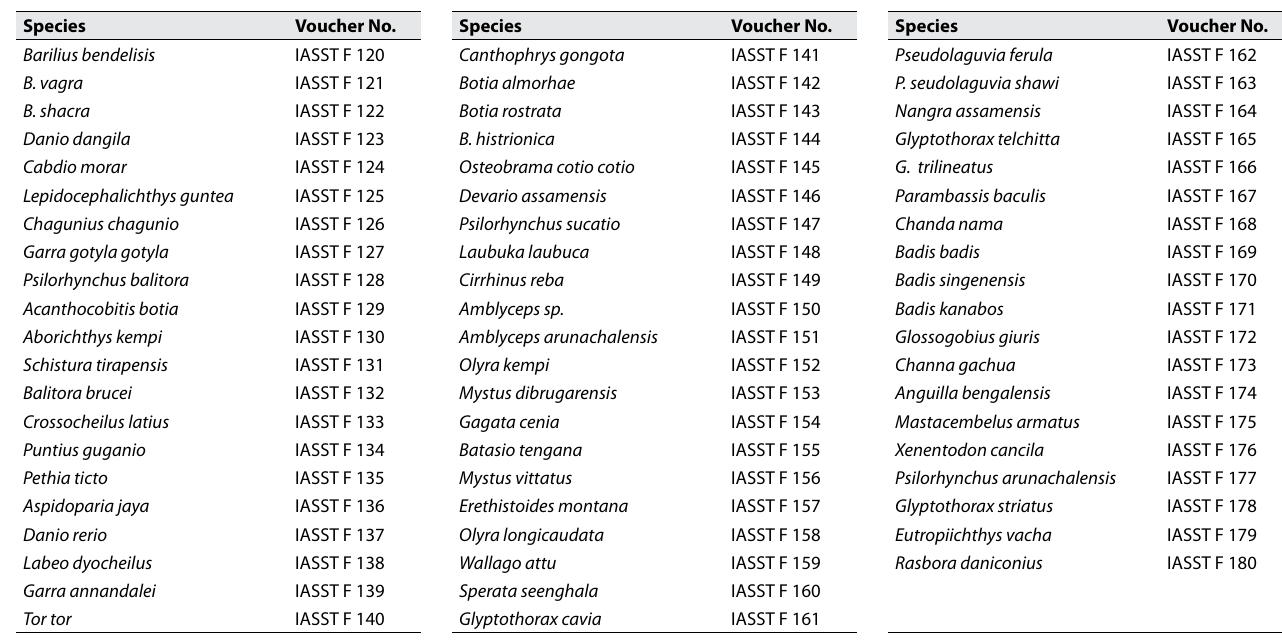
Table A1. Voucher numbers of the samples deposited in the museum of Institute of Advanced Study in Science and Technology